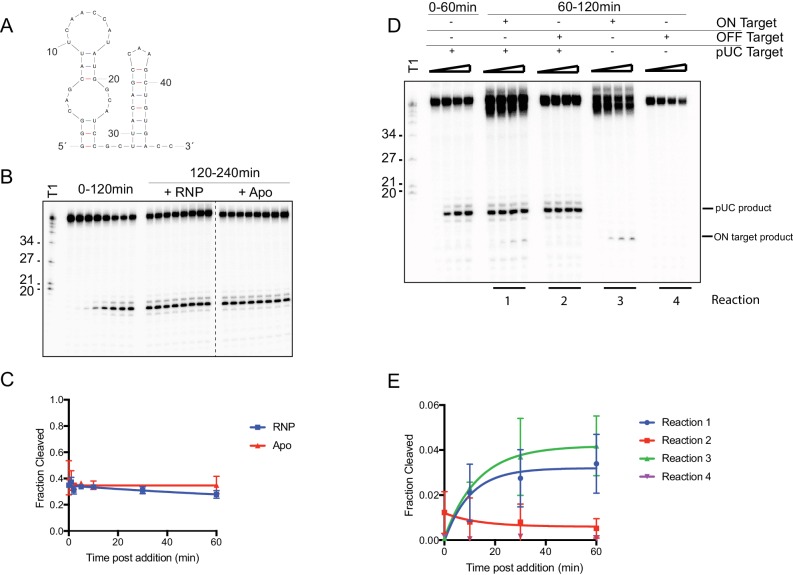
RNA cleavage is limited by the RNA target.(A) Predicted secondary structure of target RNA used in this study. (B) In vitro cleavage assay of ssRNA with SauCas9 was conducted for 2 hr (time points: 0, 1, 2, 5, 10, 30, 60, 120 min). The reaction was split and SauCas9-sgRNA RNP or apo SauCas9 were added. The reaction was further incubated at 37˚C and additional time points at were taken to check for additional cleavage of the target. Time points were taken at 0, 1, 2, 5, 10, 30, 60, and 120 min post-RNP/apo SauCas9 addition. (C) Fit for data in (B) was determined in Prism using a single-exponential decay model. Error bars represent the mean ± S.D. (n = 3). (D) In vitro cleavage assay of two ssRNA targets added sequentially. After 60 min incubation of SauCas9 with the pUC target, another target containing either the same recognition sequence (ON target – reaction 1) or an unrelated sequence (OFF target – reaction 2) were added to the reaction. Cleavage was assayed for an additional 60 min (time points: 0, 10, 30, 60 min). Reactions containing only the second target (Reactions 3 and 4) were conducted with SauCas9 RNP that was incubated for 60 min at 37˚C prior to addition to the cleavage reaction. (E) Quantification of cleavage of second target in (D) for time points after addition. Fit was determined in Prism using a single-exponential decay model. Error bars represent the mean ± S.D. (n = 3).10.7554/eLife.32724.014Figure 2—figure supplement 1—source data 1.Quantification of ssRNA after additional protein and target spike-in.